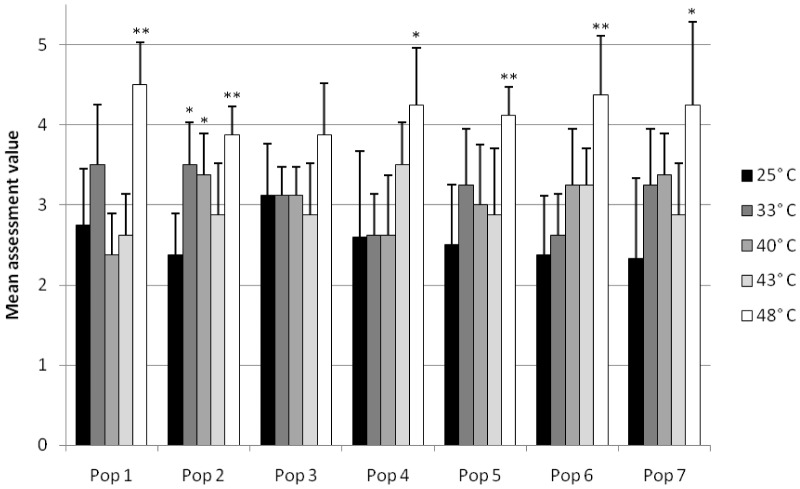
The condition of the calcium cells of the hepatopancreas.Mean assessment values for each population at elevated temperature. Shown are means and SD; n = 8. Asterisks show significant differences of the respective exposure groups compared to the control at 25°C after Bonferroni correction: 0.0025<P≤0.0125: (*) and 0.00025<P≤0.0025 (**).